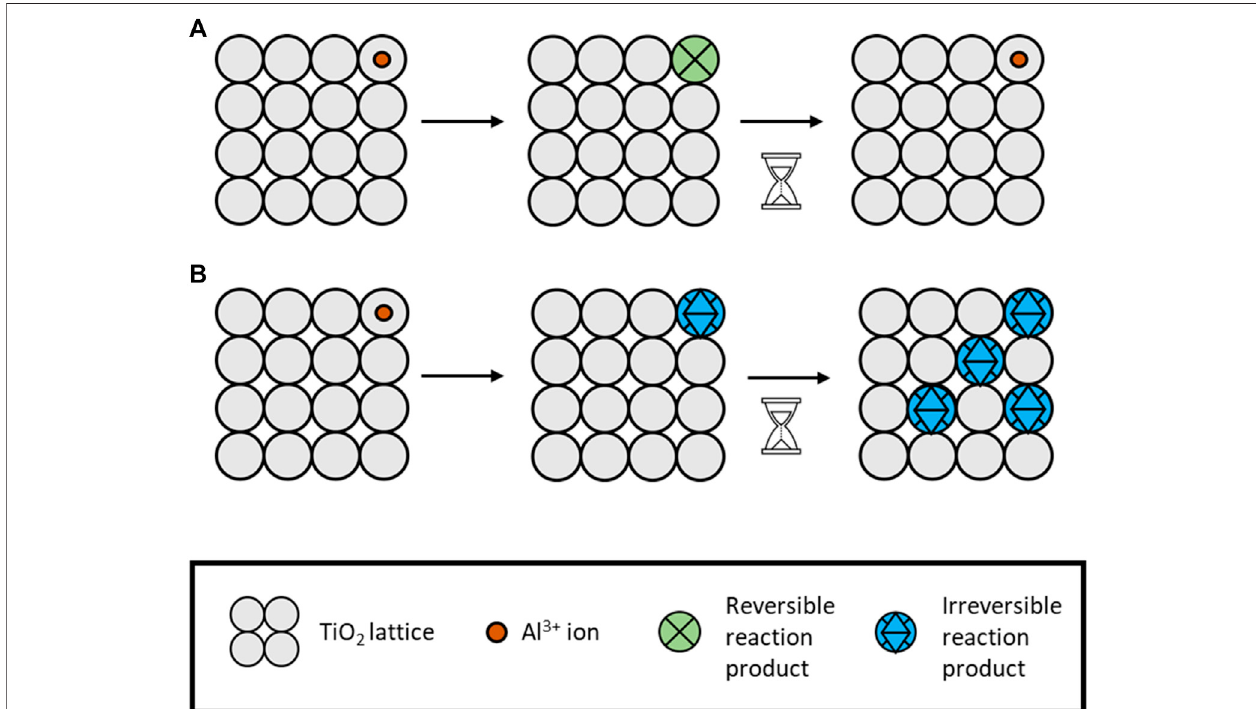
FIGURE 3 | Illustration of reversible (A) and irreversible (B) reactions on the electrode material.